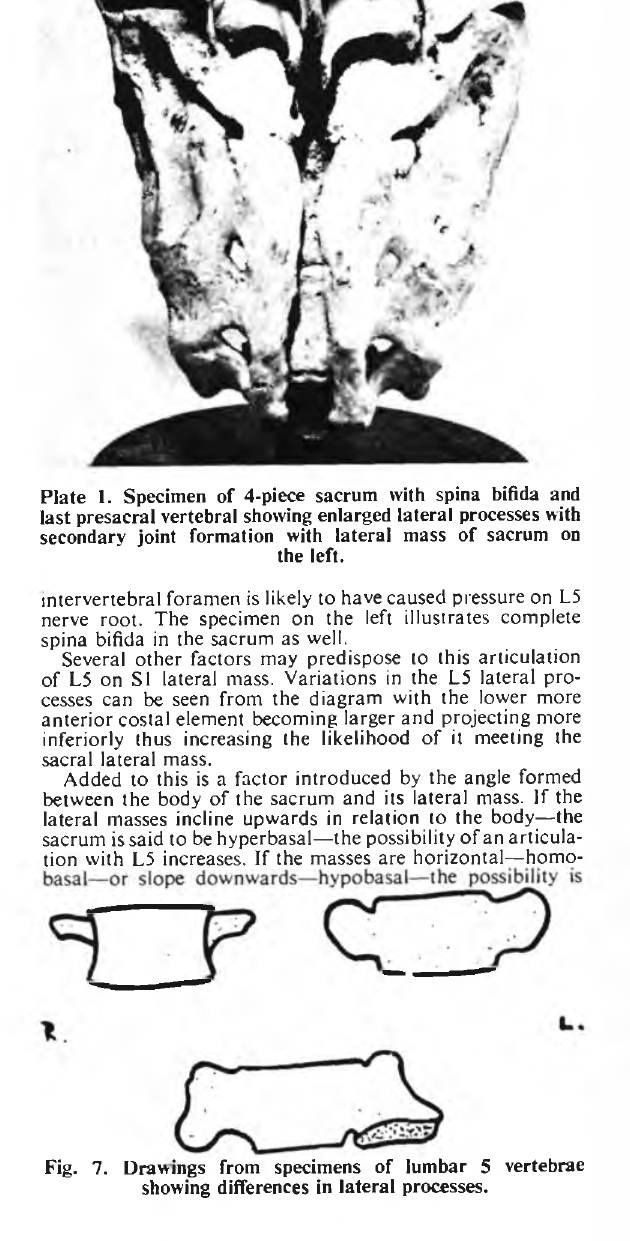
Fig. 7. Drawings from specimens of lumbar 5 vertebrae showing differences in lateral